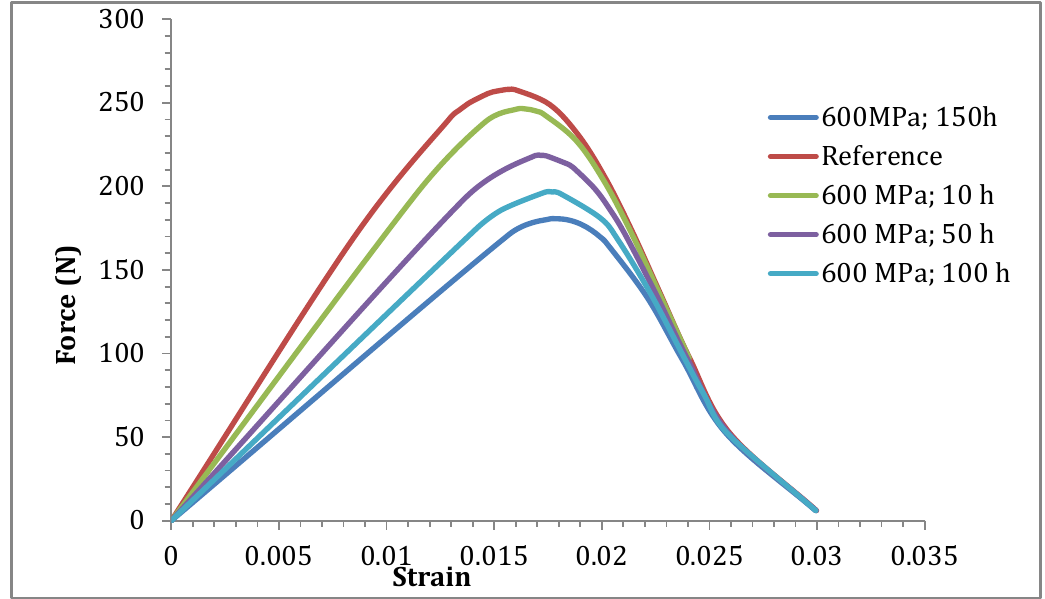
Figure 8. Predictions of residual force-strain behaviour after static fatigue under constant stress of 600 MPa.